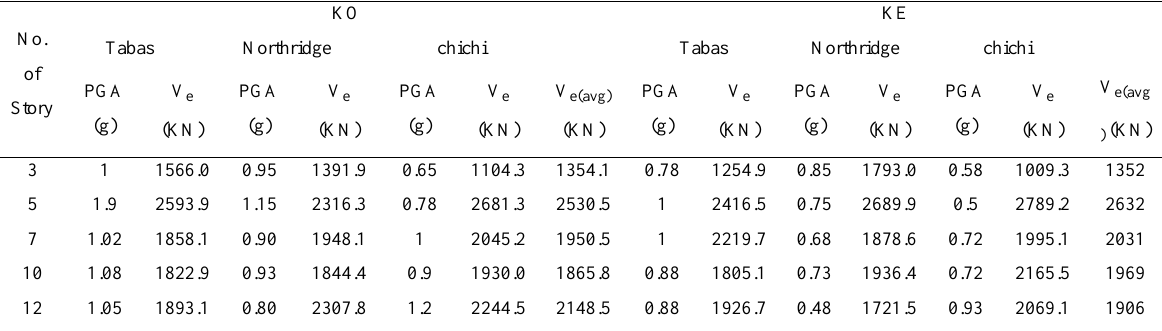
Table. 6. Linear maximum base shear and PGA for KO and KE under Tabas, Northridge and Chichi ground motion.